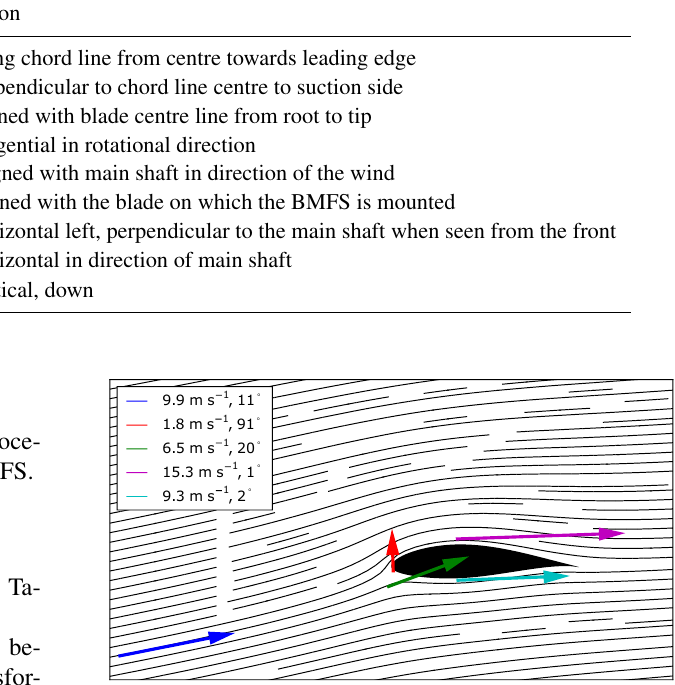
table generated by 2-D computational fluid dynamic